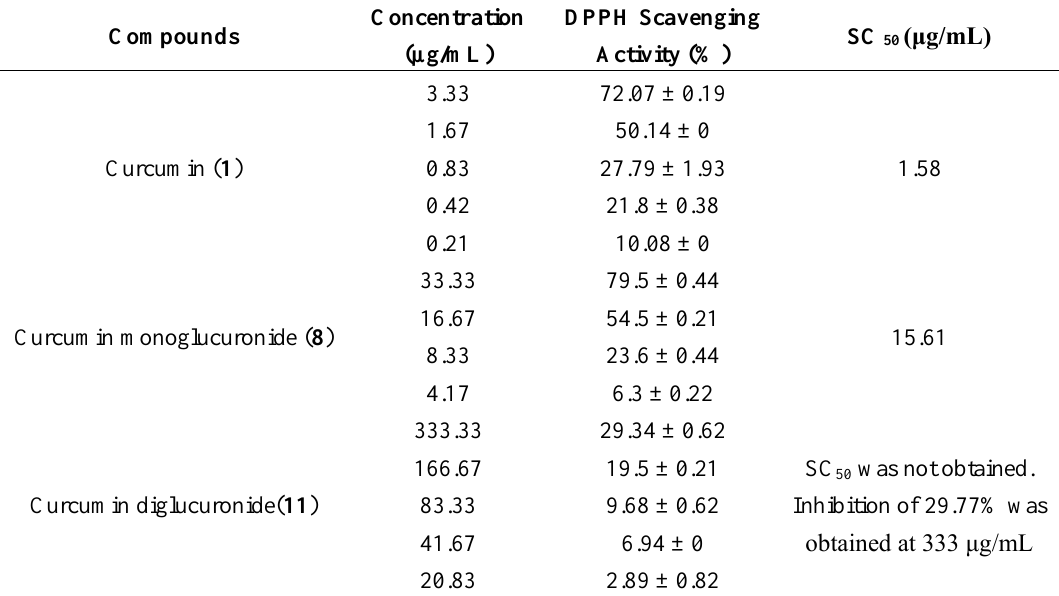
Table 1. Results of DPPH assay (values represent means ± SD).